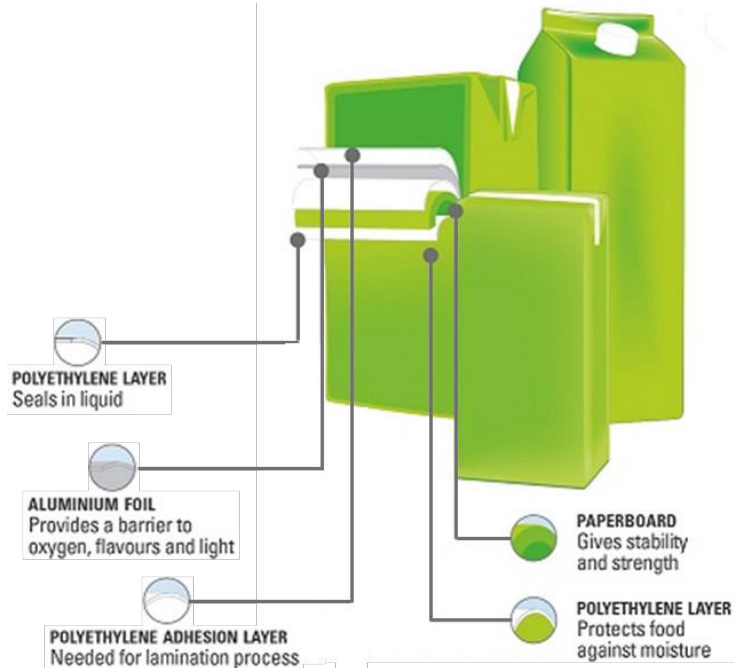
Figure 1. Structure of multilayer cartons, adapted from [1].